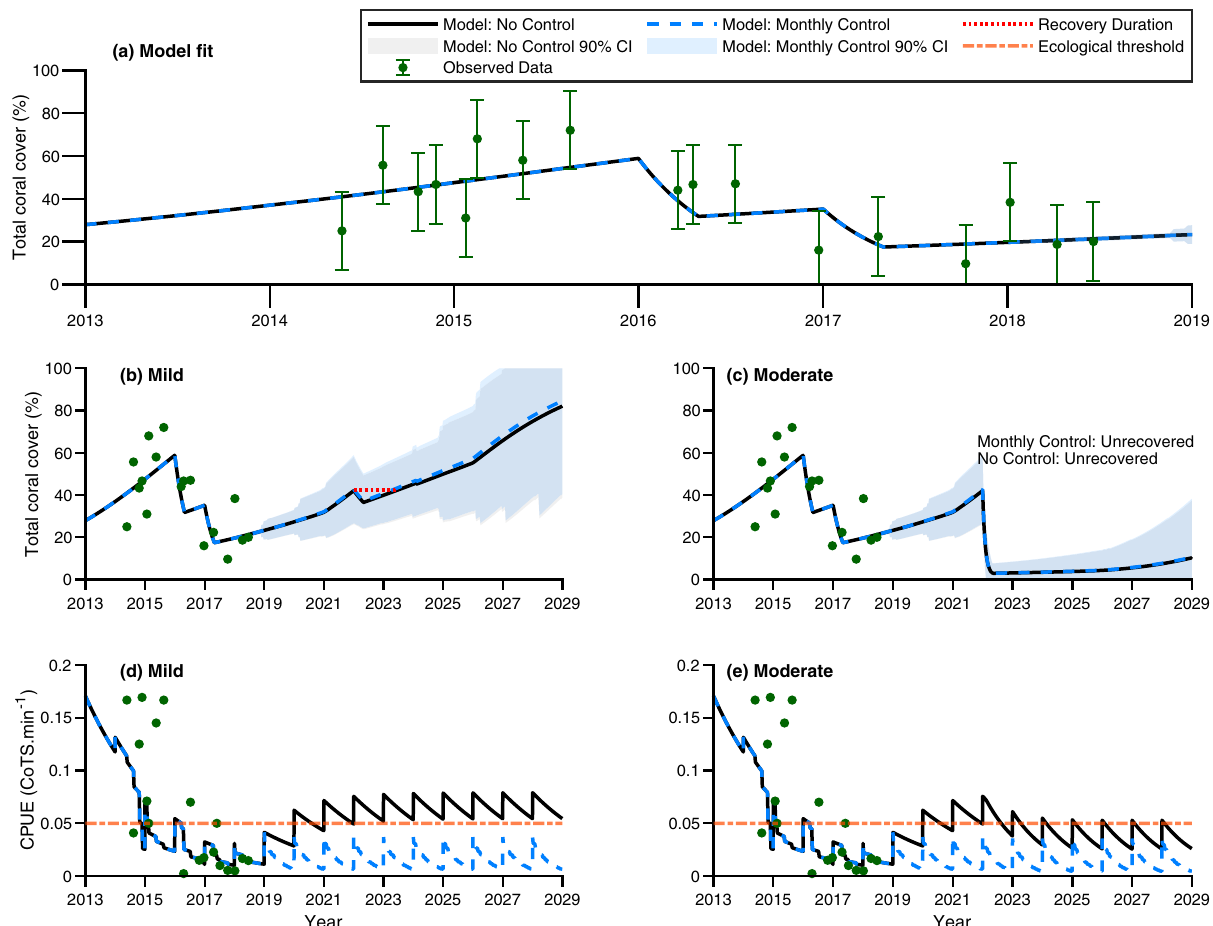
Fig. 4 Management site 7 model fi ts and total coral cover (%) and catch-per-unit-effort (CPUE; CoTS.min − 1 ) of crown-of-thorns star fi sh (CoTS) trajectories under no manual control vs monthly manual control given no adaptive capacity ( A = 0). In all panels, black solid lines de fi ne the no control scenario and the blue dashed line de fi nes the controlled scenario. a The model fi t to total coral cover for the management site (data points plotted with error bars depicting ±90% CI; green points and error bars). Each data point constitutes a single observation. Variance for the site was calculated at the Maximum Likelihood Estimate (MLE) which was simultaneously fi tted to n = 539 observations (both coral cover and CoTS CPUE, see Supplementary Table 7). The 90% CIs were calculated based on the variance obtained for Management site 7 ’ s coral cover series and the number of observations in